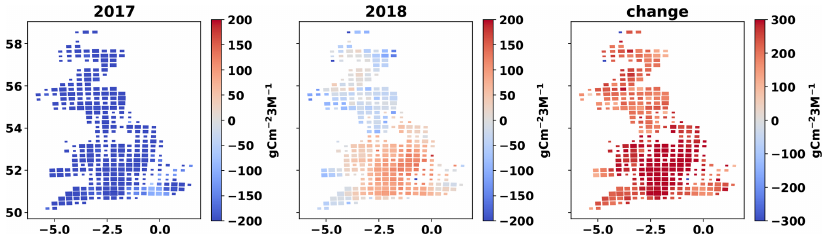
Figure 7. Cartograms of cumulative NEE for summer 2017, summer 2018 and change in summer NEE between 2017 and 2018 (cumulative NEE 2018 − cumulative summer NEE 2017). The mean MDF-predicted seasonal NEE of all fields in each cell is presented. The size of cells is adjusted according to the number of simulated fields within it.